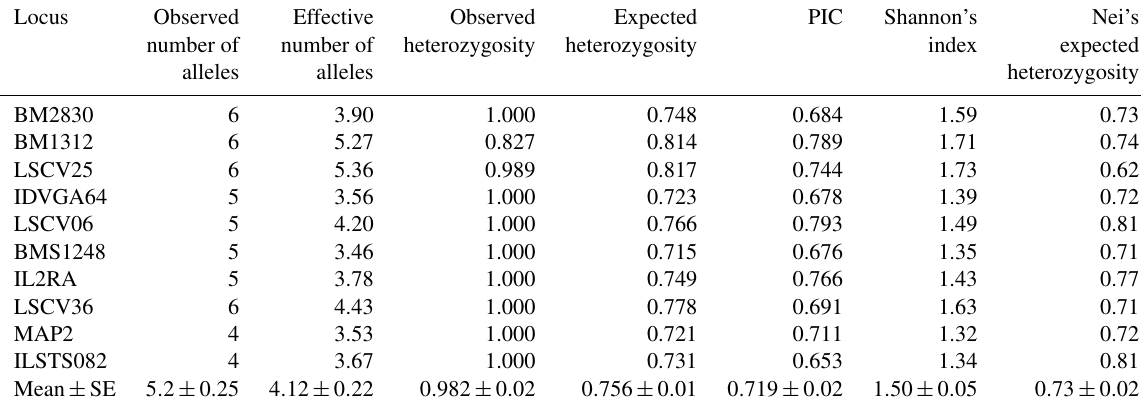
Table 2. Genetic diversity indices at each microsatellite locus in Markhoz goat. Locus Observed Effective Observed Expected number of